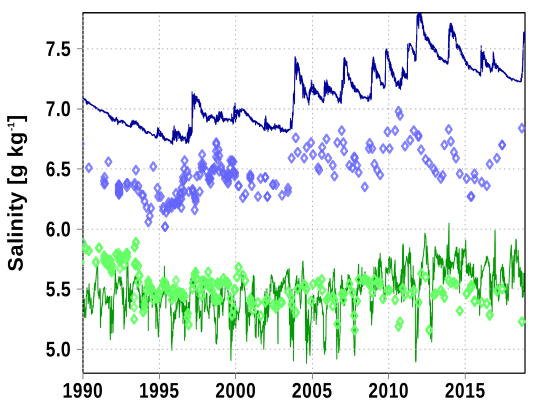
Figure A5. Surface (green) and bottom (blue) salinity at station SR5. Solid line: model; diamonds: observations (http://www.ices.dk, last